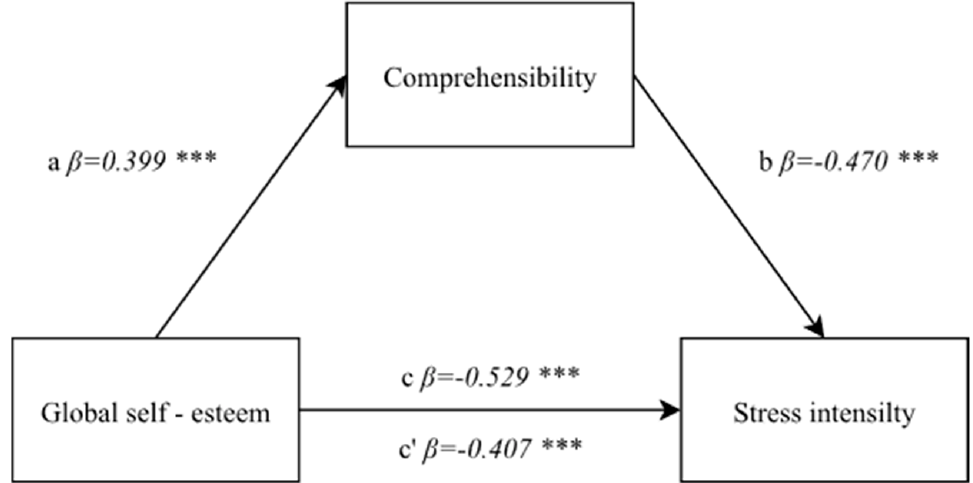
Figure 3. A model of the mediatory role of a sense of comprehensibility between self-esteem and the stress intensity. Statistically significant: *** p < 0.001.